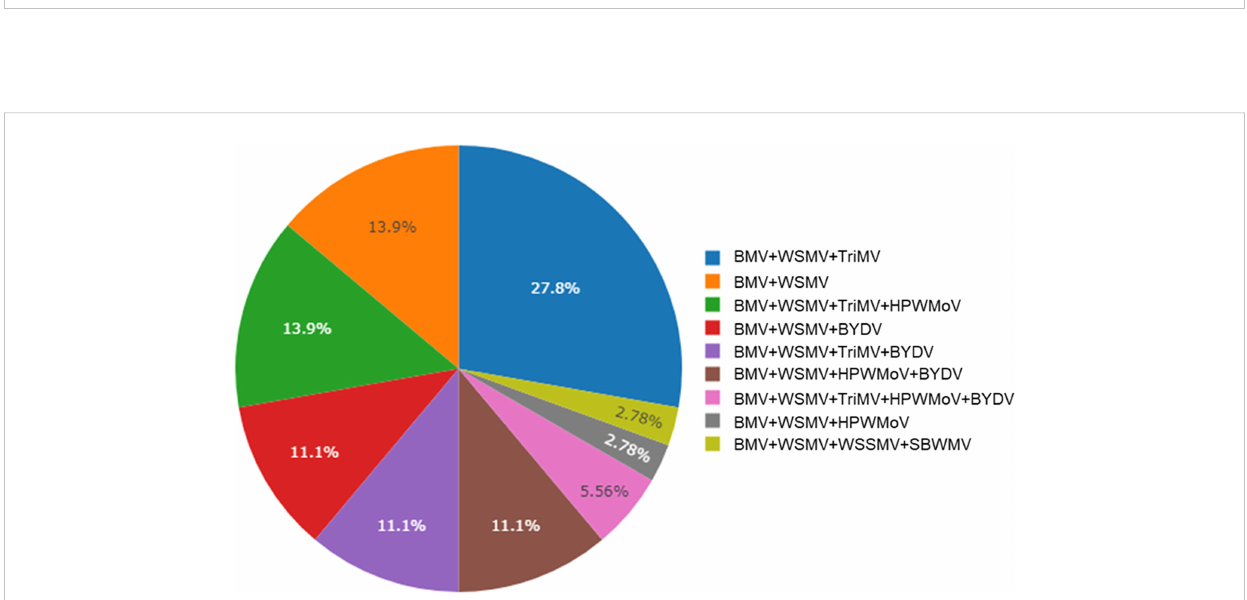
FIGURE 3 Percent incidence (n = 37) of brome mosaic virus co-infected with of wheat streak mosaic virus (WSMV), triticum mosaic virus (TriMV), High Plains wheat mosaic emaravirus (HPWMOV), brome mosaic virus (BMV), barley yellow dwarf virus (BYDV), wheat spindle streak mosaic virus (WSSMV), cereal yellow dwarf virus (CYDV), soilborne wheat mosaic virus (SBWMV)in leaf samples collected from Kansas wheat fi elds detected by Nanopore sequencing. Virus-like symptomatic wheat leaves were collected from winter wheat fi eld in 2019, 2020, and